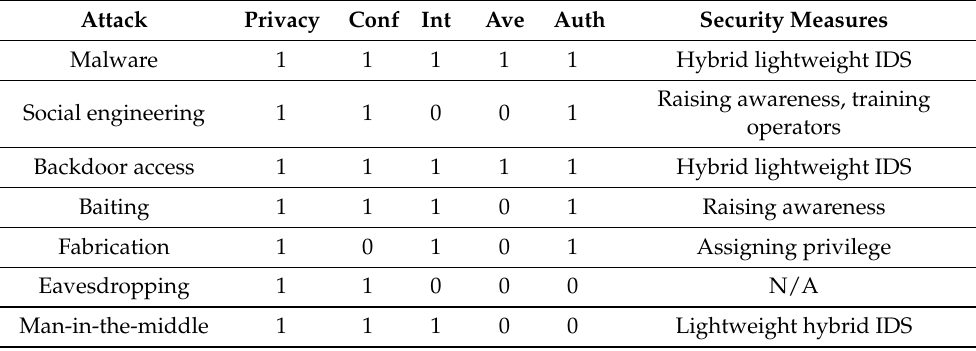
Table 2. Drone cyberattacks (1: available; 0: not